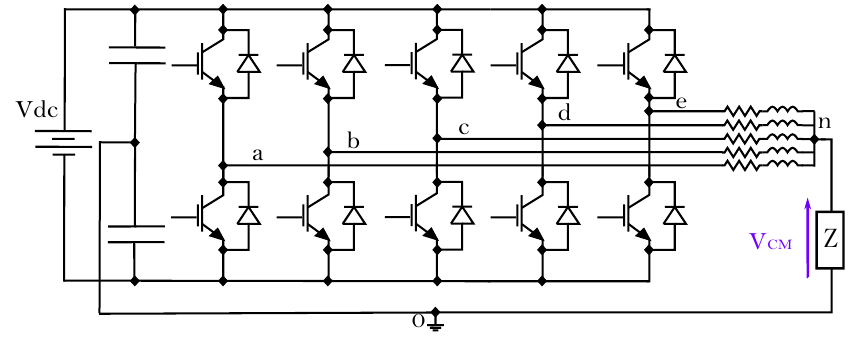
Figure 1. CMV in a five-phase power system.